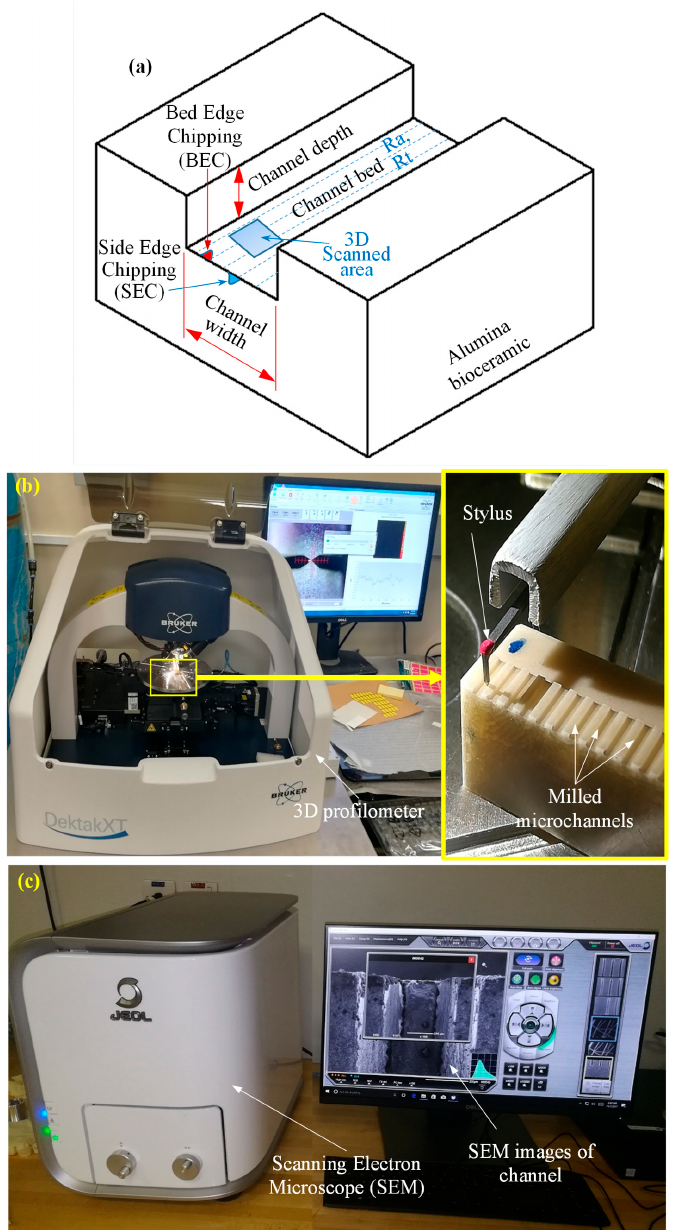
Figure 4. Outputs measurement procedure: ( a ) 3D schematic of the microchannel; ( b ) surface roughness measuring set up; and ( c ) surface morphology measuring set up.